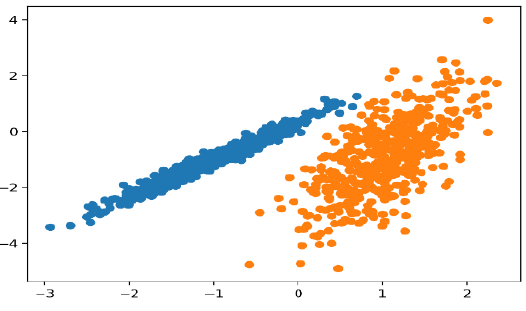
Figure 10. Clusters generated using Gaussian